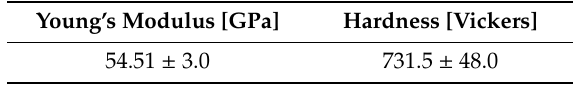
Table 1. Mechanical properties of BGMS10 disks, as determined by depth-sensing micro-indentation: elastic modulus and hardness.